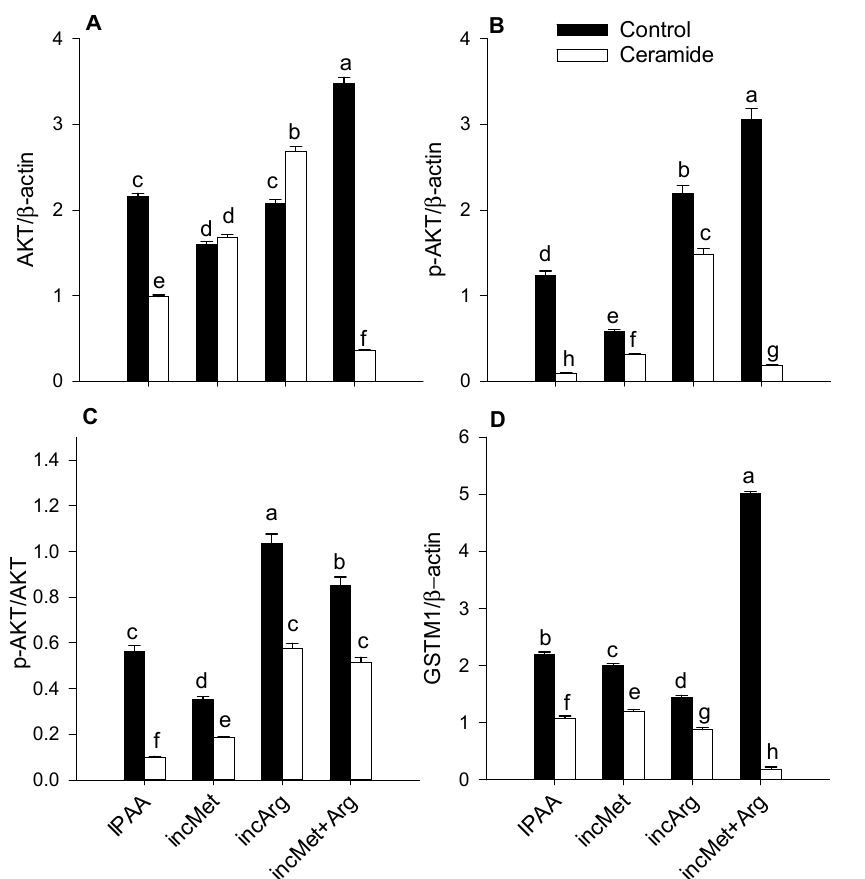
Figure 1. Protein abundance (relative to β -actin) of AKT (total, panel A ), p-AKT (active, panel B ), ratio of p-AKT/AKT (panel C ), and GSTM1 (panel D ) in subcutaneous adipose tissue cultured with different levels of Met or Arg and stimulated with ceramide. Control media contained an ideal AA profile (IPAA) with ratios of Lys:Met 2.9:1 and Lys:Arg 2:1. Treatment media was supplemented with greater amounts of Met or Arg to achieve ratios of Lys:Met 2.5:1 and Lys:Arg 2:1 (incMet), Lys:Met 2.9:1 and Lys:Arg 1:1 (incArg), or Lys:Met 2.5:1 and Lys:Arg 1:1 (incMet + Arg). Different letters indicate differences between treatments (Met × Arg × Ceramide p < 0.05). AKT = protein kinase B; GSTM1 = glutathione S-transferase Mu 1. Data are LS means, n = 4 cows per group, ± pooled SEMs. Control Ceramide